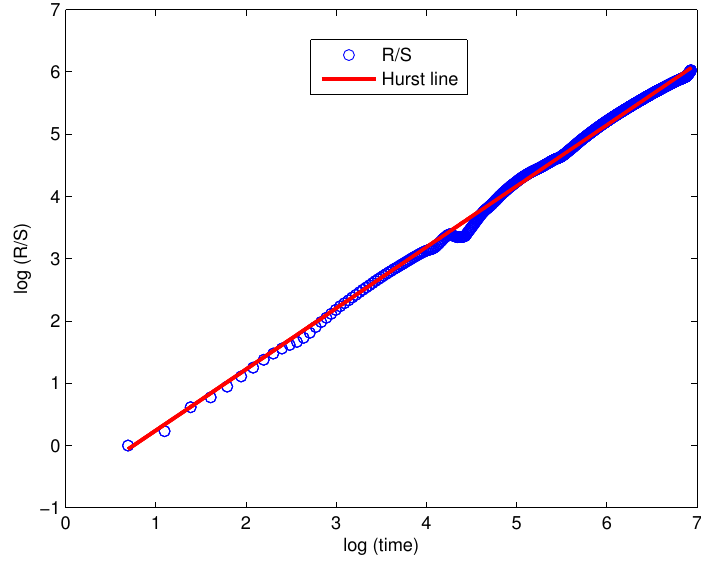
Figure 3. The slope of the Hurst line.